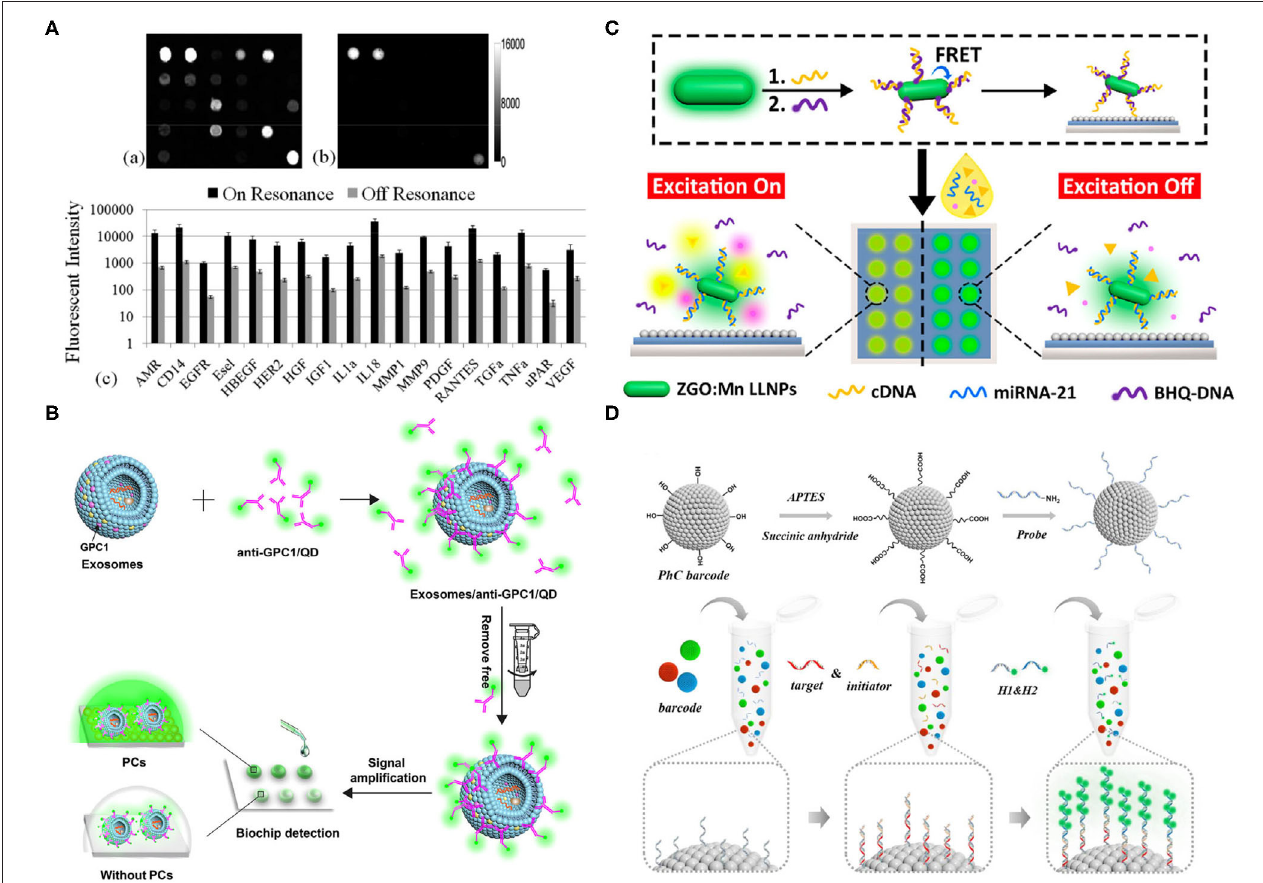
FIGURE 1 | (A) On (left)/off (right) resonance fluorescence images when a photonic crystal (PC) array was exposed to the second-highest analyst concentration; images were taken by identical photomultiplier tube gain settings. Below is the quantitative fluorescent intensity for different functional assays, using on/off resonance; 11- to 20-fold intensity difference was observed when using the on resonance (Huang et al., 2011). (B) A schematic of the PC signal amplification when measuring tumor exosomes. Biotinylated anti-glypican-1 (GPC-1) antibodies were first conjugated with streptavidin-coated quantum dots, which are specifically recognized GPC1 + exosomes. The signal amplification was conducted by the PCs ( Zhang J. et al., 2020). (C) A schematic of miR-21 detection, using a developed biochip. The single-stranded DNAs (ssDNAs) were functionalized onto long lifetime luminescence nanoparticles (LLNPs) and hybridized with black-hole-quencher-labeled DNAs (BHQ-DNAs), which were free after the adding of miR-21 since miR-21 attracted ssDNAs. BHQ dye-generated luminescence signals were improved by PCs (Wang et al., 2019). (D) A schematic of a photonic crystal (PC) barcode functionalized with amino groups and probes that target different microRNAs (miRNAs). Below is the schematic of hybridization chain reaction (HCR). The initiator chain and target chain were paired and captured on the PC barcode. Then, the hairpin fluorescence sequences were added to form a copolymer for enhancing the signal ( Wei X. et al., 2020). All copyright 2021 American Chemical